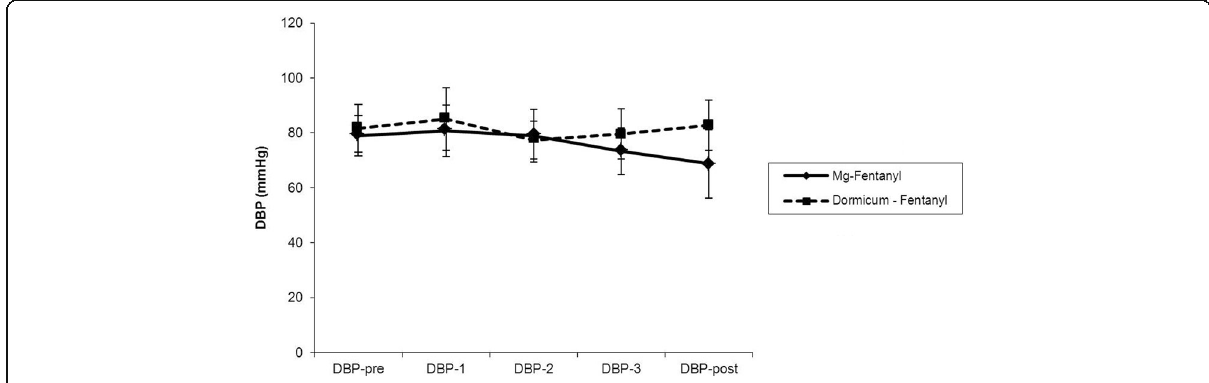
Fig. 3 Changes in diastolic blood pressure (DBP) in both study groups. Markers represent means and error bars represent 95%